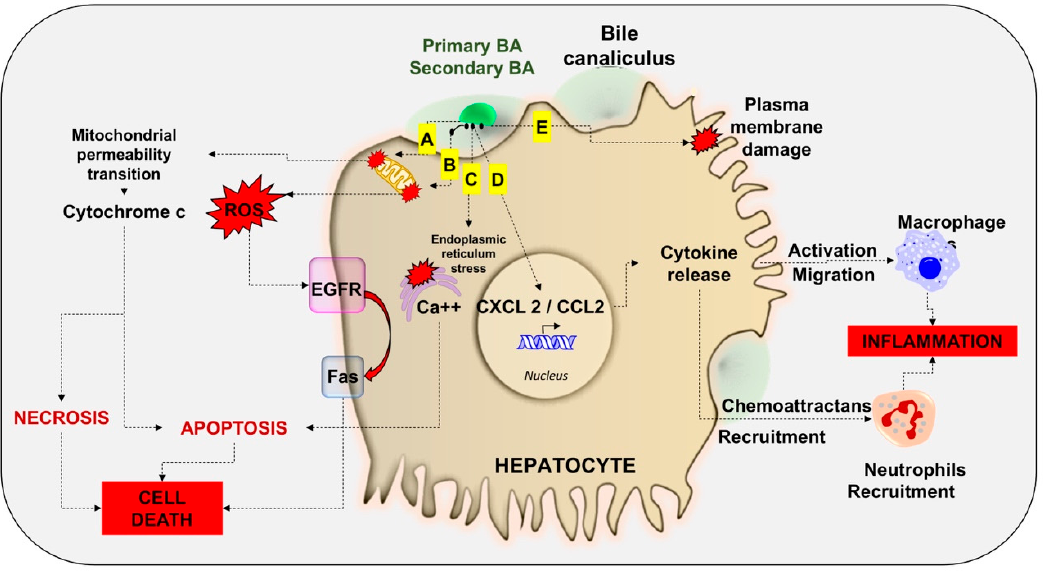
Figure 5. The cascade of damage in the hepatocytes, as triggered by excess of primary and / or secondary BA. ( A ) Mitochondrial damage and release of reactive oxygen species (ROS), with activation of epidermal growth factor receptor (EGFR) and Fas-death receptor pathway. ( B ) Endoplasmic reticulum stress with cytosolic Ca ++ release contributing to apoptosis. ( C ) Induction of chemokine (C-X-C motif) ligand 2 (CXCL2) and chemokine (C-C motif) ligand 2 (CCL2), which act as chemoattractants of neutrophils and activator agents of macrophages. ( D ) Damage at the level of hepatocyte plasma membranes. ( E ) Damage at the level of hepatocyte plasma